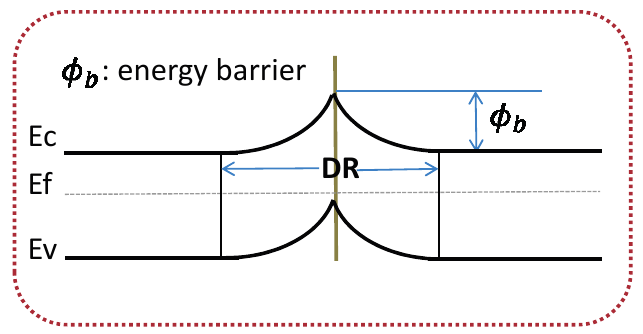
Figure 1. Proposed zinc oxide (ZnO) nanocomb based carbon monoxide (CO) gas sensor with two electrodes.